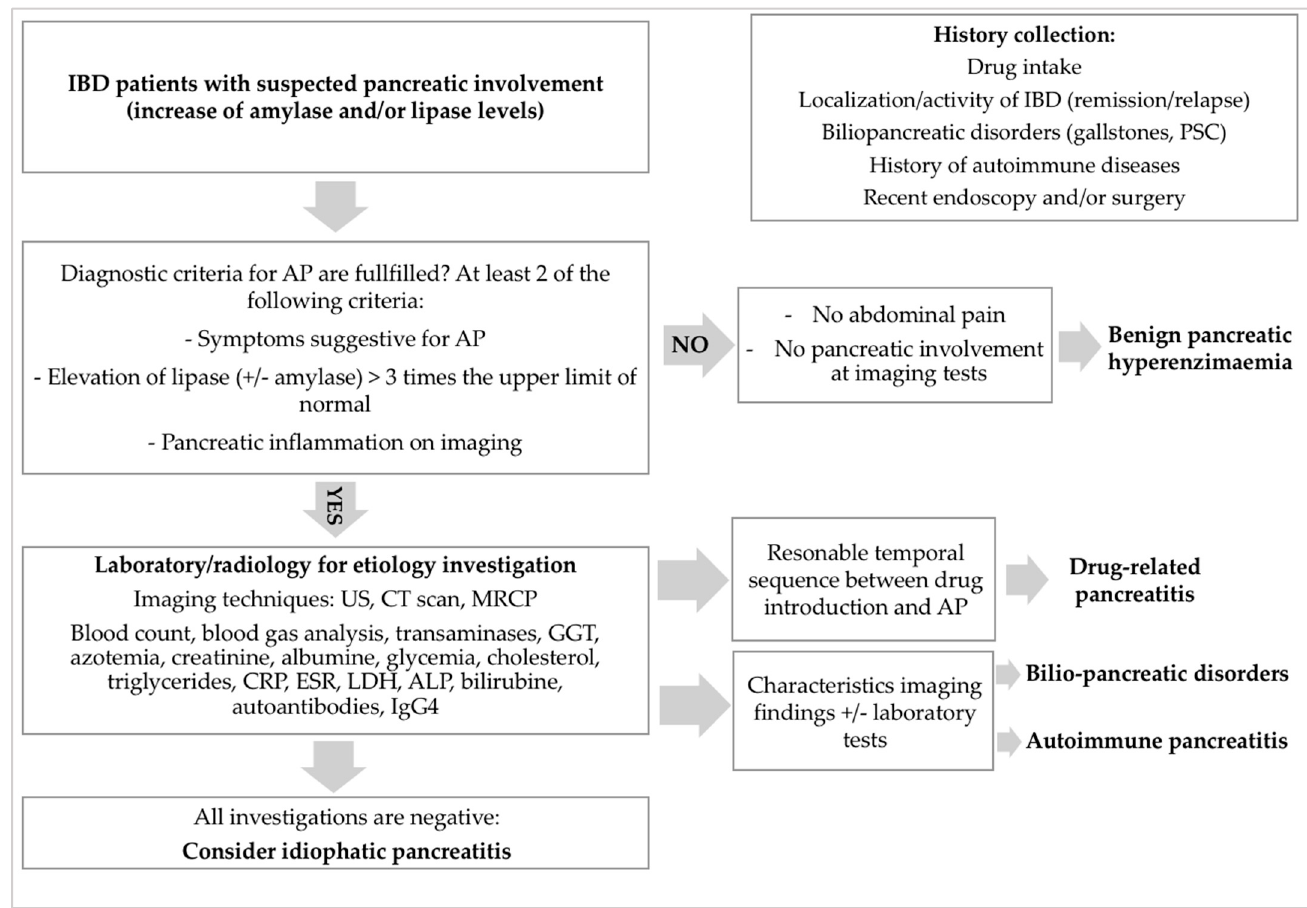
Figure 1. Diagnostic approach for suspected pancreatic disease in IBD pediatric